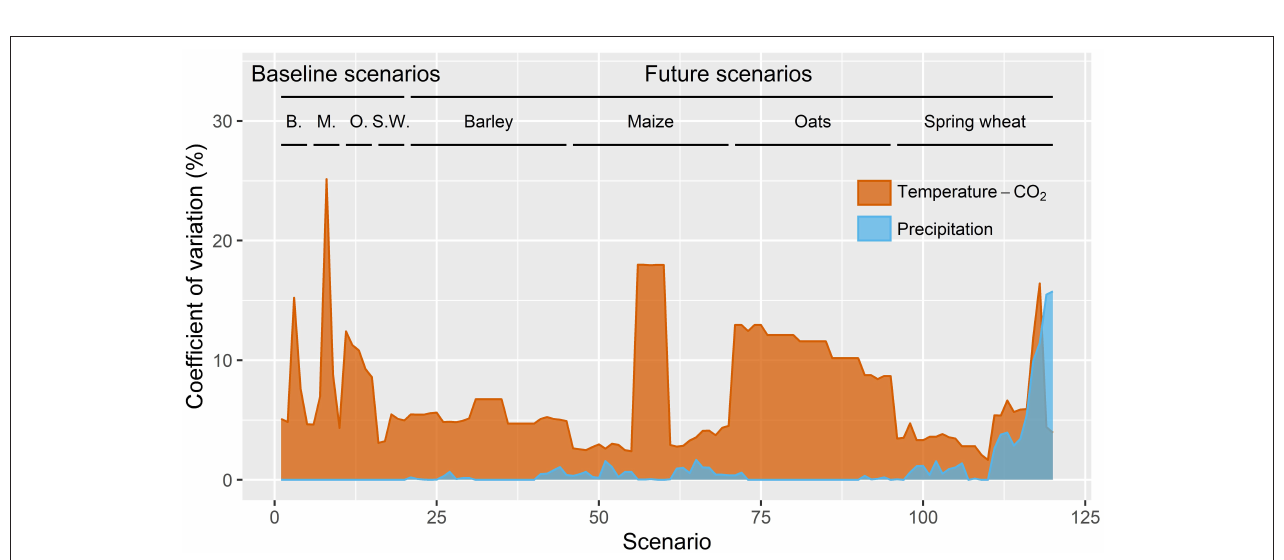
FIGURE 3 | Simulation averaged phenology-related water stress. Barley, spring wheat and to a lesser extent, maize, showed little to no water stress. Oats, on the other hand, and especially at Färjestaden, appears to have a more prononced water stress affecting its phenology, although this does not impacted its risk of failure.